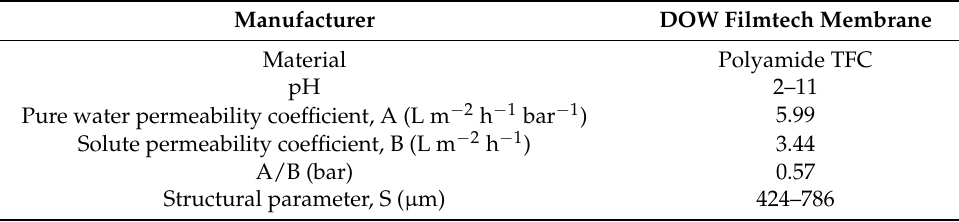
Table 2. Properties of the membrane.